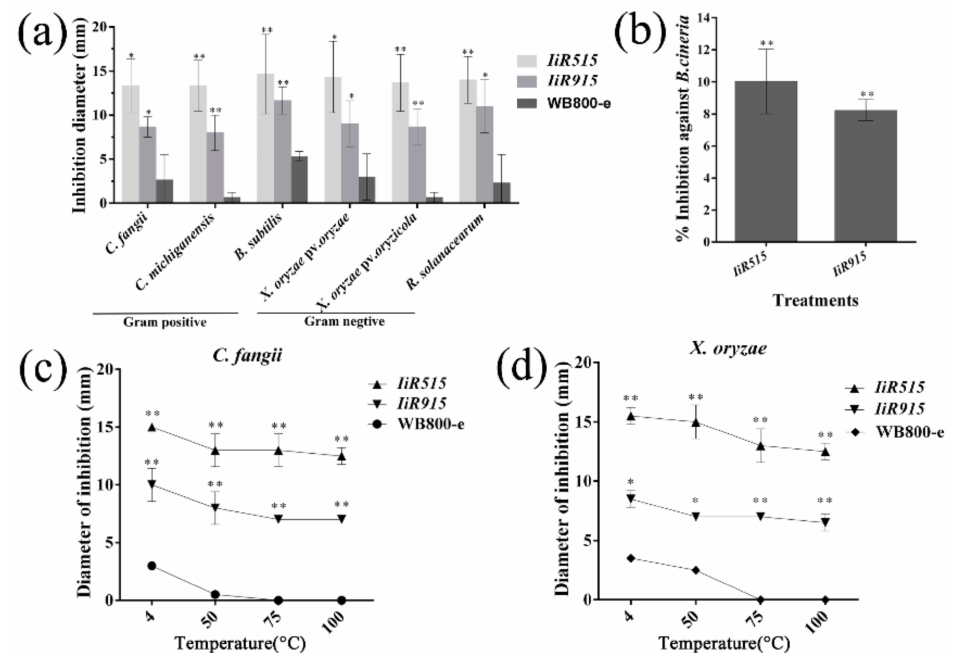
Figure 4. Analysis of potential antimicrobial peptides (AMPs) against pathogens. For antimicrobial activity assays, the B. subtilis WB800-e strain was used as a control. ( a ) Inhibition of Gram-positive and Gram-negative bacteria in response to IiR515 and IiR915 compared to WB800-e. ( b ) Percent inhibition of IiR515 and IiR915 against Botrytis cinerea compared to WB800-e. Temperature curves for ( c ) Clavibacter fangii and ( d ) Xanthomonas oryzae. Data are the mean values from three individual experiments. Vertical bars represent the SD. For significance analysis, t -tests were performed; * p < 0.05, ** p < 0.01. 2.6. Western Blots Revealed the Expression and Size of the IiR515 and IiR915 Peptides His-tag fusion IiR515 and IiR915 peptides were expressed in B. subtilis WB800 cells.